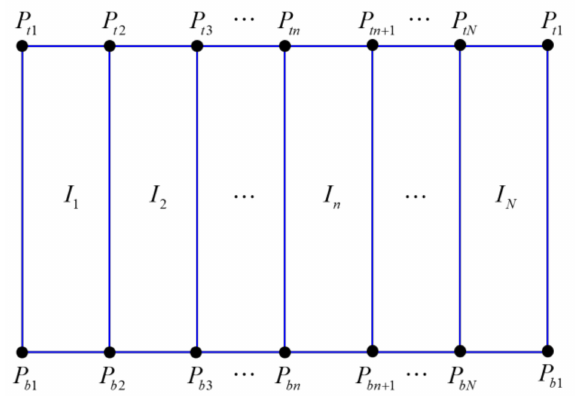
Figure 9. Splitting image I with three-dimensional points by Equations (7)–(10).